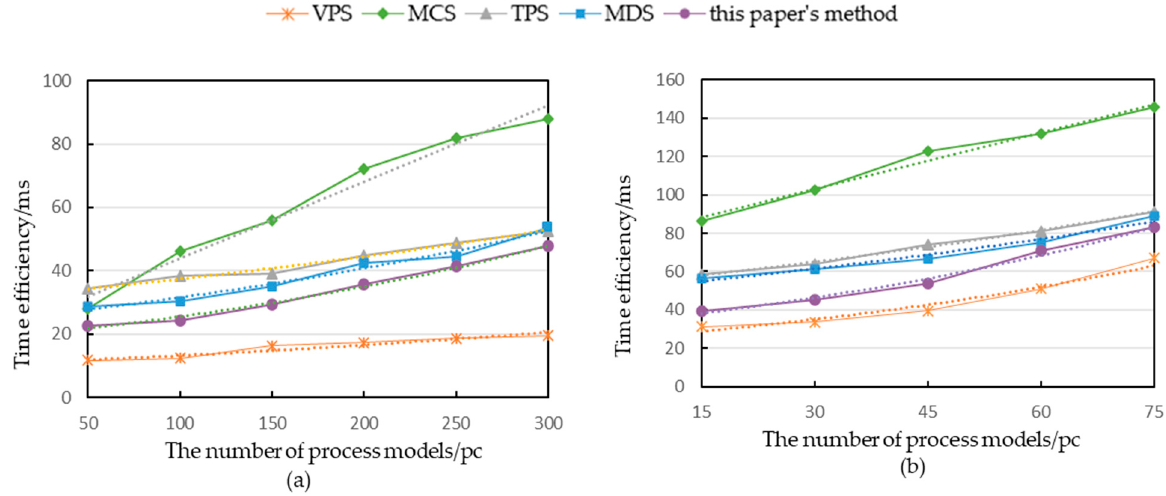
Figure 10. Time comparison of fi ve methods: ( a ) real dataset; ( b ) simulation dataset.